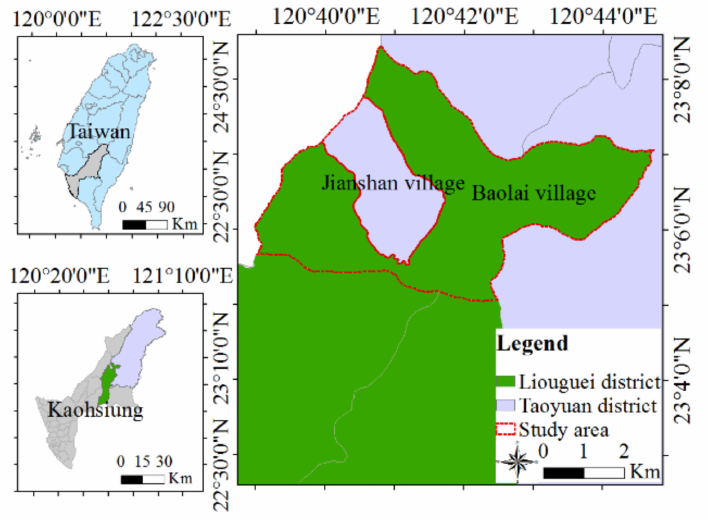
Figure 1. Research